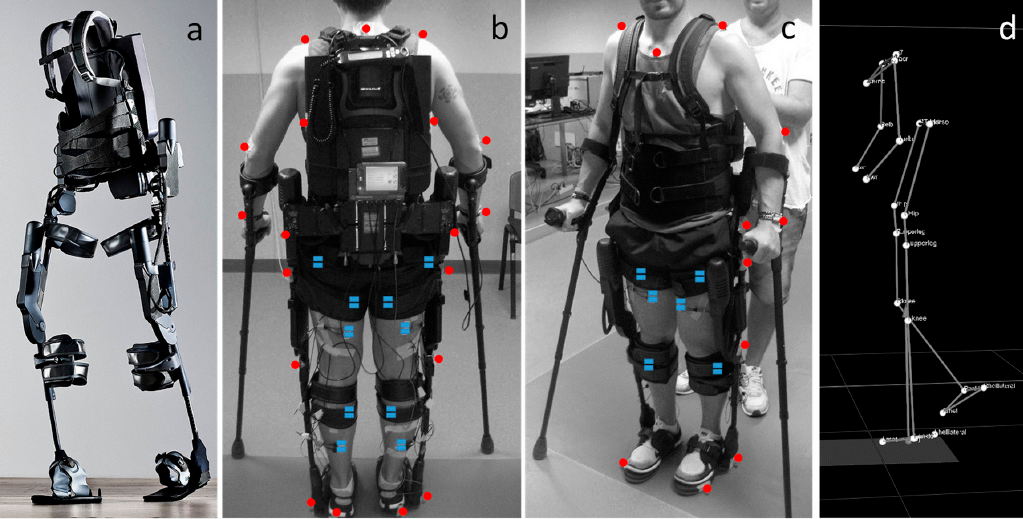
Figure 1. ( a ) Exoskeleton Ekso; ( b , c ) Participants wearing the Ekso. Red dots indicate the positions of the reflective markers for the motion analysis and the blue rectangles indicate the position of the surface electromyographic (EMG) electrodes. ( d ) Markers recorded by the motion analysis system (lateral view in the center of the motion analysis lab pathway).